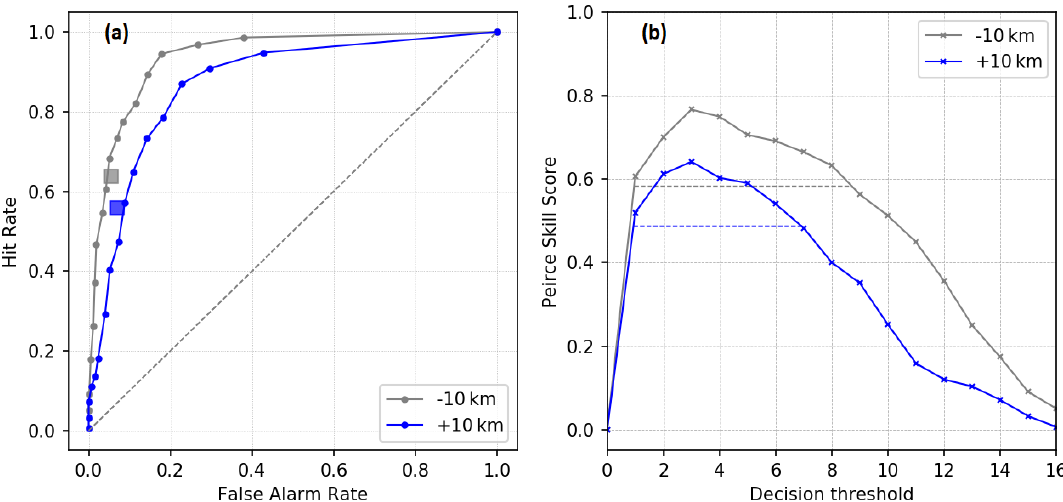
Figure 15. ROC curves (a) and the PSS as a function of decision thresholds (b) of the pX ensemble simulations performed with Pasquill stability classes by aggregating data in the two groups of stations: − 10km (Beaumont, Digulleville, Gréville, and PTILH) and + 10km (LRC, Ludiver, Octeville, and Urville). There is one curve for each group of stations. The scores are calculated using the most optimal discretization configuration ( (cid:49)t = 3 h,τ = 2 h